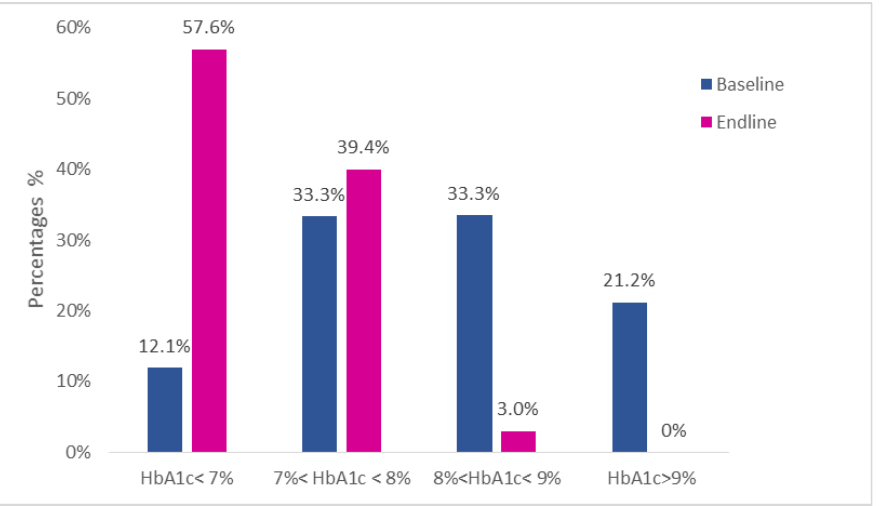
Figure 3. Percentage distribution of the glycated hemoglobin classes of the 33 patients of the study. About insulin titration, the dosage of rapid-acting insulin lowered from 18.3 ± 9.5 UI/day to 10.3 ± 6.5 UI/day with a level of significance p < 0.001. Consequently, even a reduction statis- tically significant ( p < 0.001) in total daily insulin units was observed (from 36.7 ± 14.9 UI/day to 28.9 ± 9.1 UI/day).